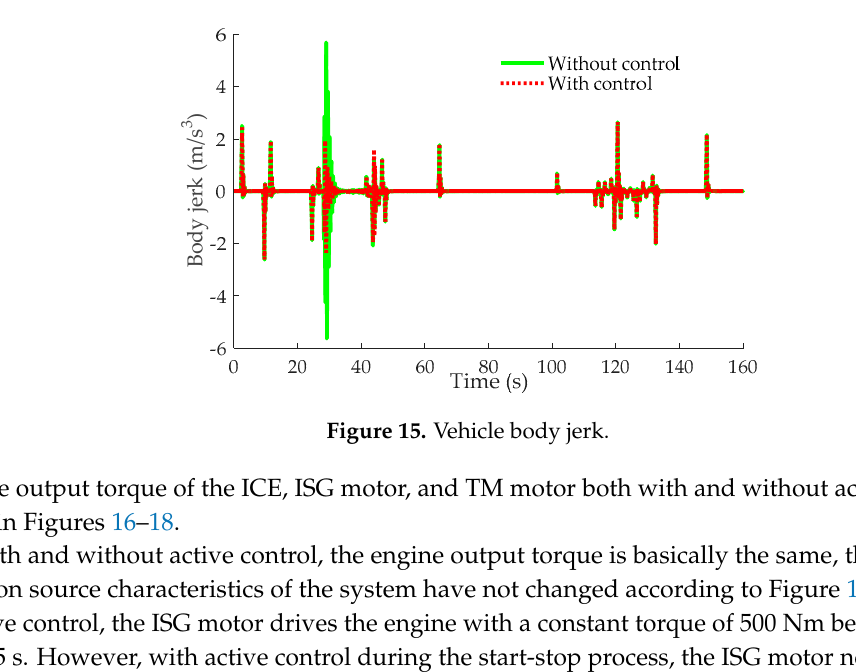
Figure 16. Engine output torque.